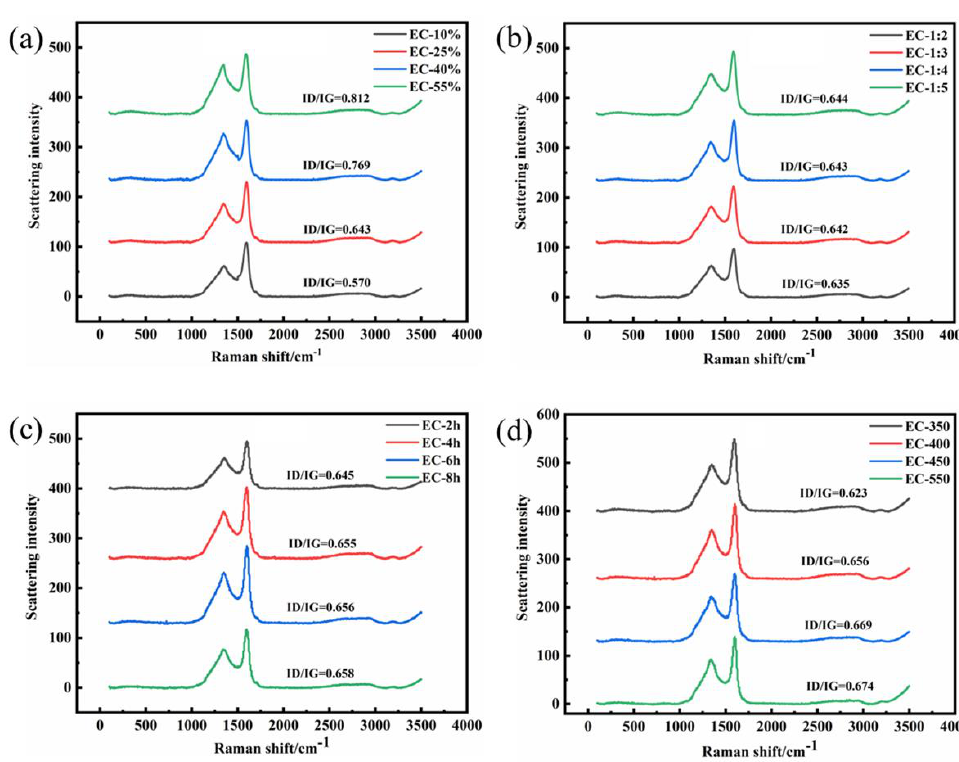
Figure 3. ( a , b , c , d )The Raman spectra of the ECs.